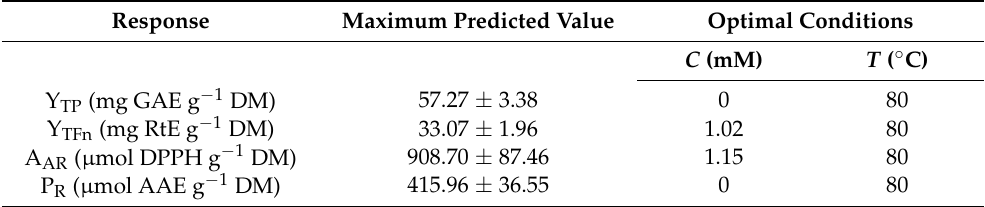
Table 4. Maximum values for each response considered and the optimal conditions, as predicted by the desirability function (Figures